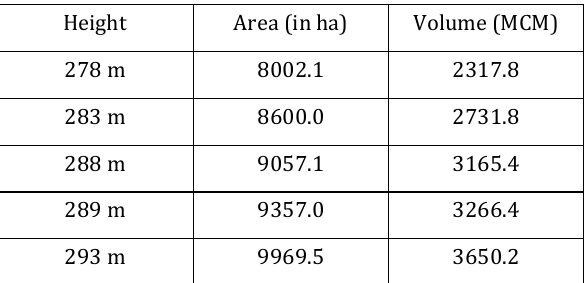
Table 6. The surface area and volume of water at different FRL levels: based on ASTER DEM and Landsat data Height Area (in ha) Volume (MCM) 278 m 8002.1 2731.8 9057.1 3165.4 9357.0